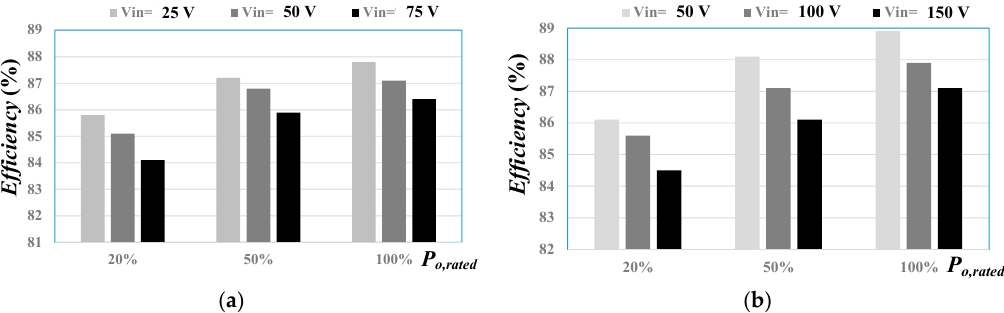
Figure 13. Measured circuit efficiencies ( a ) in low input voltage range ( b ) in high input voltage range.